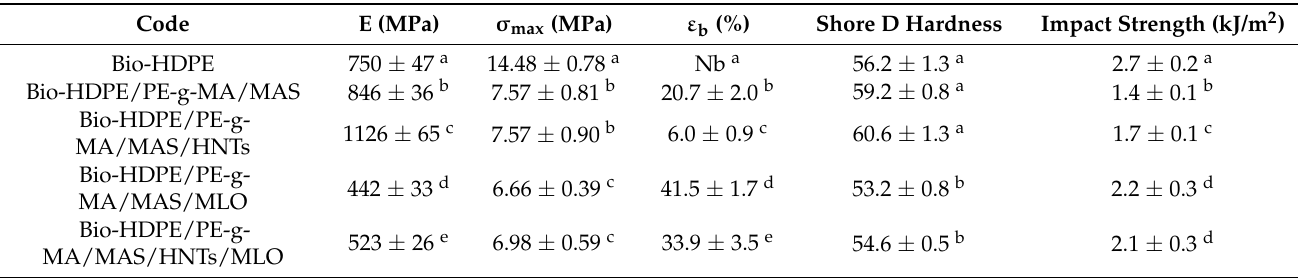
Table 2. Summary of mechanical properties of the injection-molded samples of Bio-HDPE blends. Tensile modulus (E), maximum tensile strength ( σ max ) elongation at break ( ε b ), Shore D hardness, and impact (Charpy) strength.